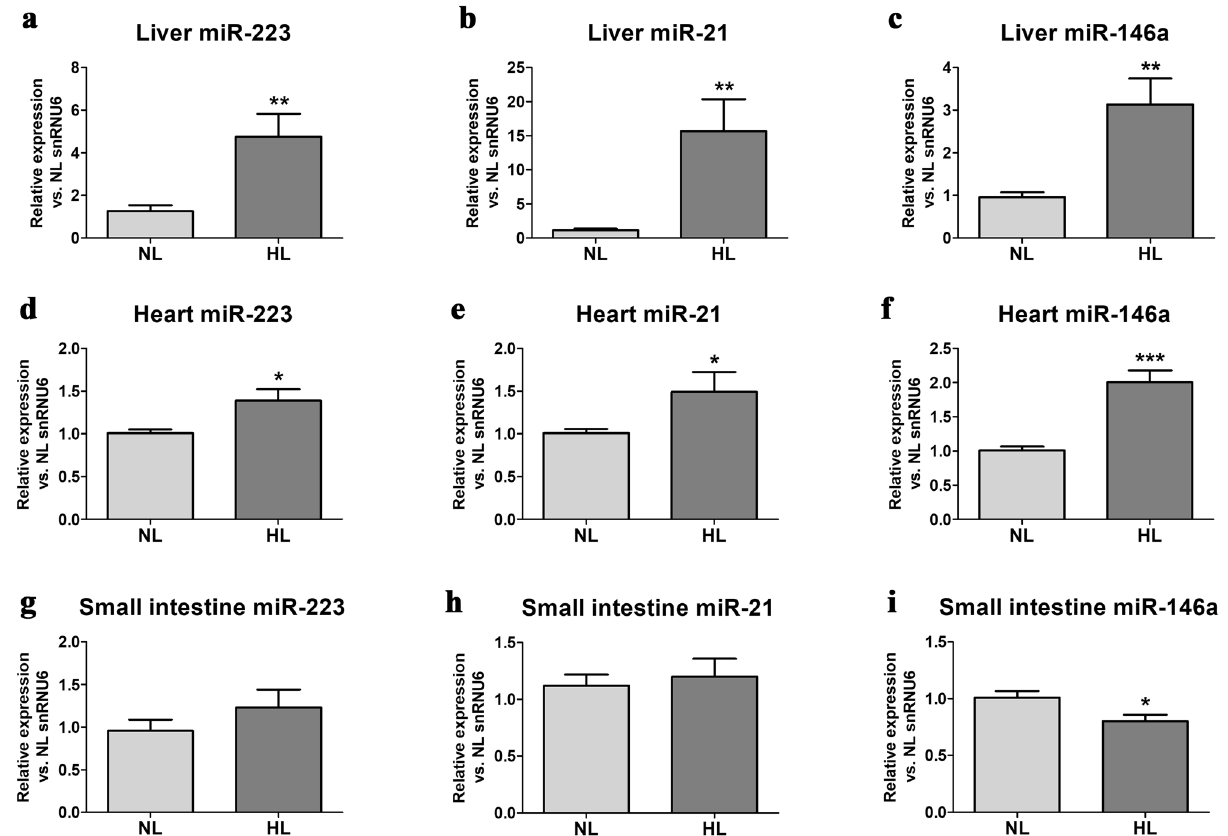
Figure 4. Expression levels of selected miRNAs (miR-223, miR-21 and miR-146a) in liver ( a – c ), left ventricle of the heart ( d – f ), and small intestine ( g – i ) from normolipidemic (NL) hamsters and high-fat diet (HFD)-induced hyperlipidemic (HL) hamsters from the validation group after 21 weeks of diet. *p < 0.05, **p < 0.01, ***p < 0.001 vs NL group (n = 10 animals per group, Mann–Whitney U